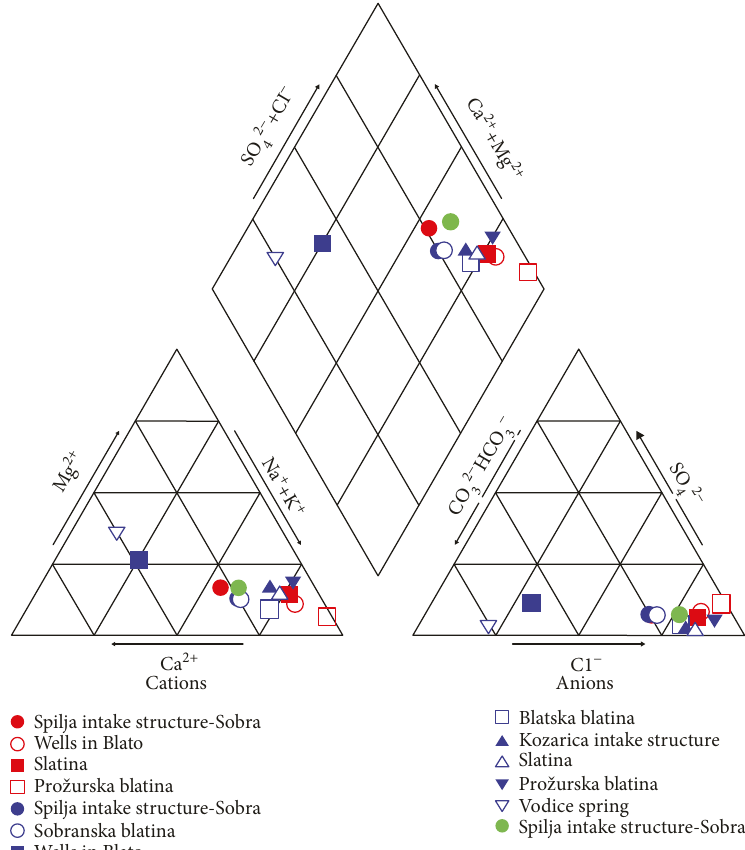
Figure 6: Piper diagram constructed from major ion compositions of samples shown in Table 1 (red symbols: MIN 2005; blue symbols: MAX 2006; green symbol: MIN